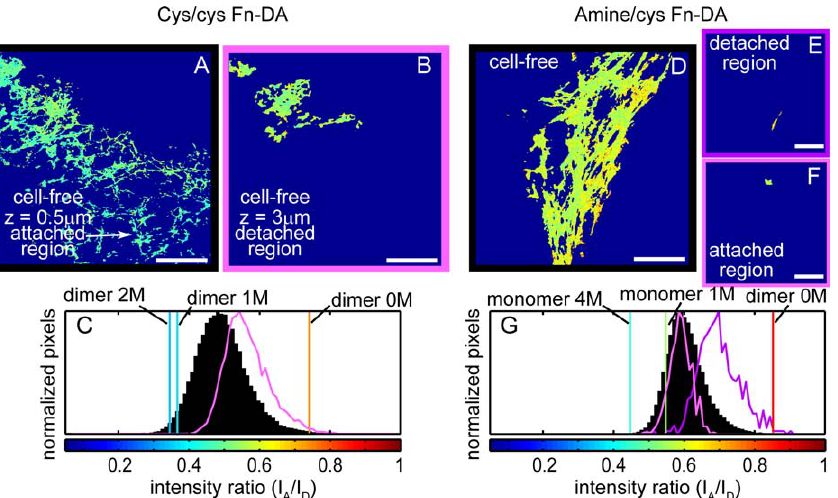
Figure 6. Fully Relaxed Fn-DA Does Not Assume the Fully Compact Conformation Cys/cys Fn-DA (A–C) or amine/cys Fn-DA (D–G) was incorporated into fibroblast matrix on Fn-u that was adsorbed to plasma cleaned PDMS, and after cell extraction the substrate was relaxed to 4/5 (A and B; 3.7% transverse stretch) or 3/5 the starting length (D–F; 10% transverse stretch). I A / I D ratiometric images of cys/cys Fn-DA–containing matrix are shown at the PDMS–ECM interface (A), where a portion of the cell-free fibers are still attached to the substrate, and from the same field of view but acquired 3 l m above the PDMS surface (B), where the strain-free Fn mat randomly diffused around its points of attachment to the underlying ECM. Histograms are shown for all pixels within the field of view at the substrate (C; black) and from the upper, strain-free confocal slice (C; pink). An I A / I D ratiometric image of amine/cys Fn-DA is shown with both detached (E) and still-attached (F) regions of matrix within the same confocal slice. Region of interest analysis was used to generate histograms (G0 for all pixels within the detached (E and G; purple) and attached (F and G; pink) regions of matrix, which were overlaid on a histogram of all pixels in the field of view (black). Scale bars ¼ 50 l m.